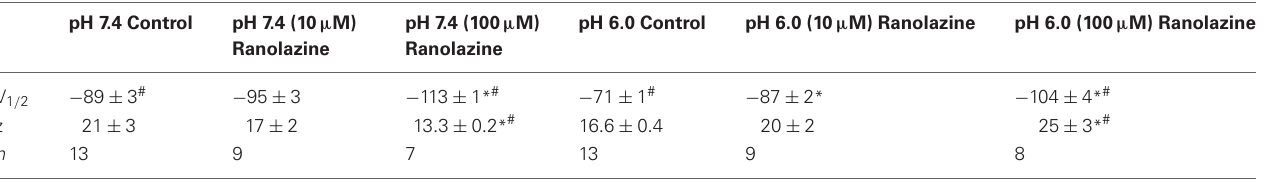
Table A9 | Steady state slow